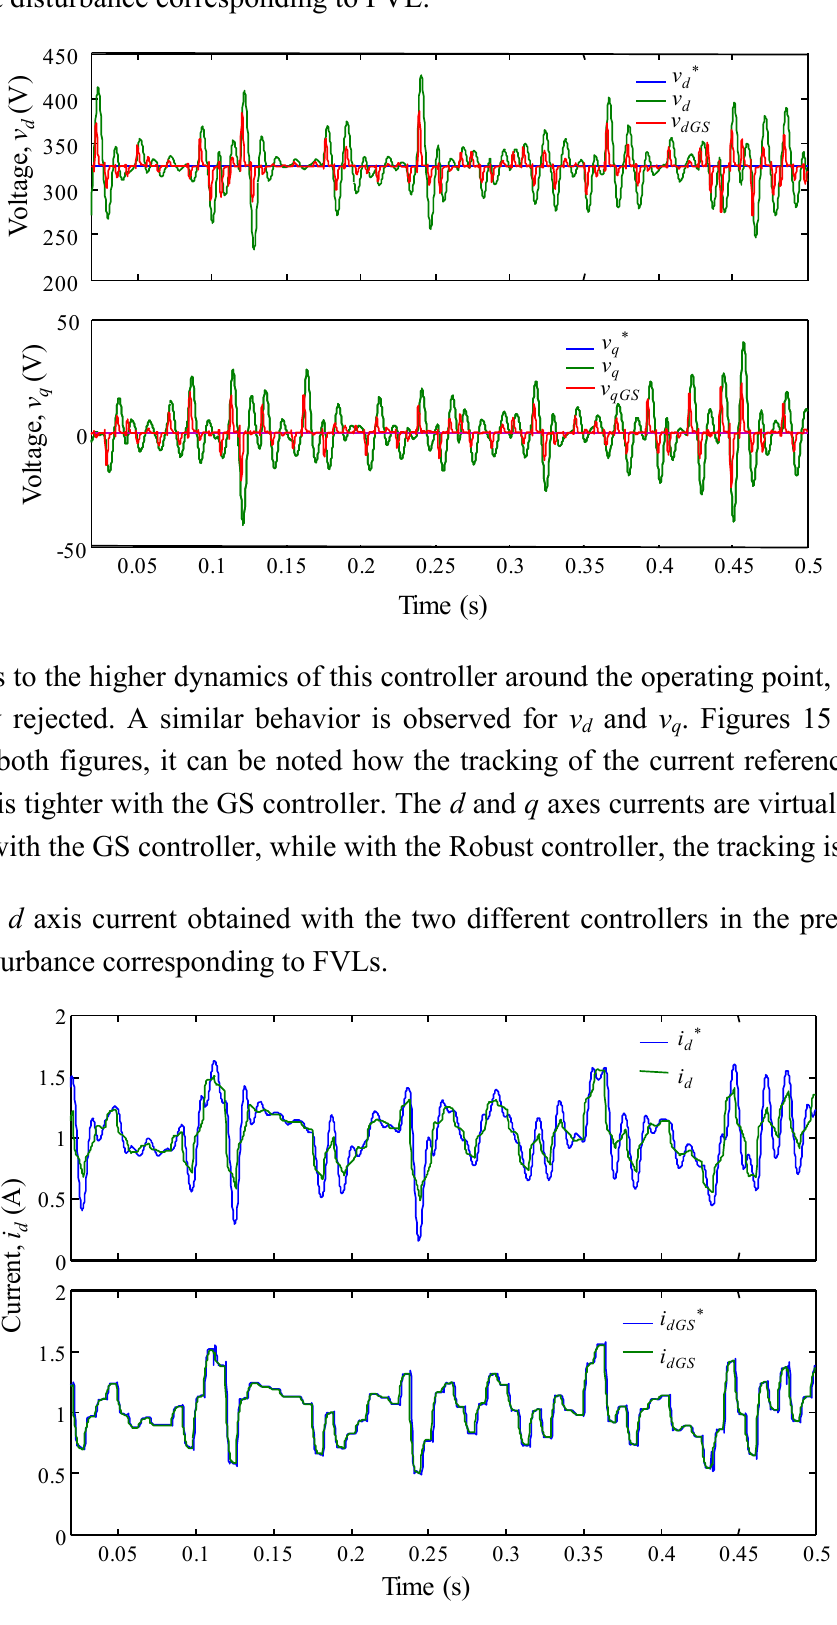
Figure 14. Voltage time series obtained with the two different controllers in the presence of a current disturbance corresponding to FVL.